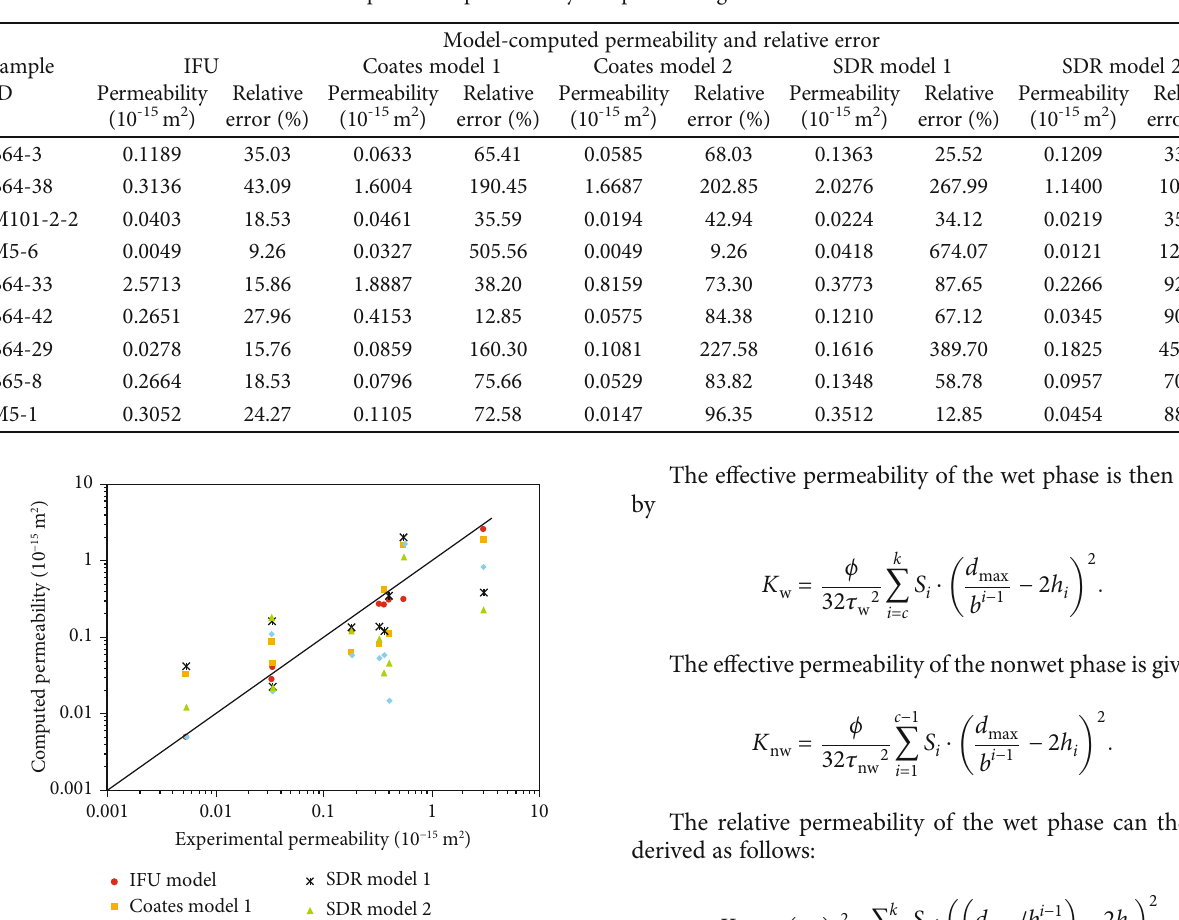
Table 5: Comparison of permeability computed using the IFU and classic models.